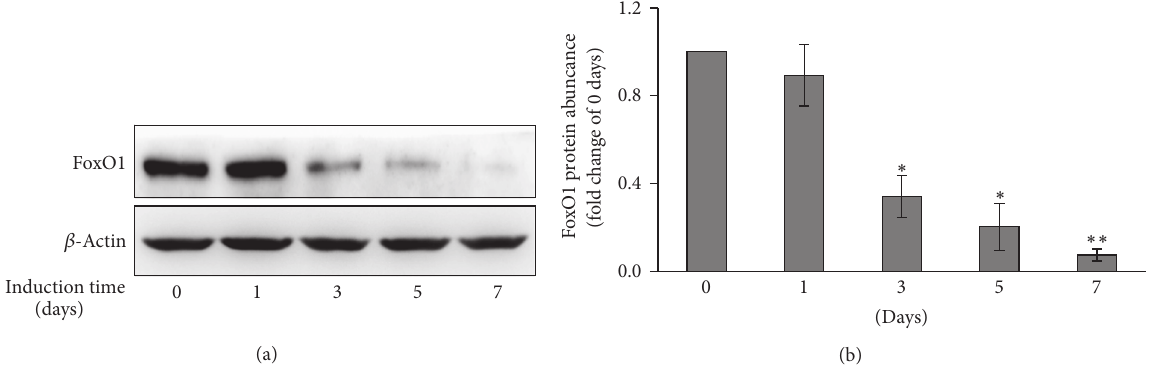
Figure 2: Reduced FoxO1 protein level during induction of human pancreatic progenitor cells. (a) Time course analysis of FoxO1 expression in human pancreatic progenitor cells after induction of differentiation for the time as indicated. Expression of FoxO1 protein was determined by Western blotting. 𝛽 -Actin was used as loading control. (b) Data were normalized to the level of 𝛽 -actin and expressed as fold change relative to control. Values are means ± SEM of 3 independent experiments per each group. ∗ or ∗∗ , 𝑝 < 0.05 or 0.01.